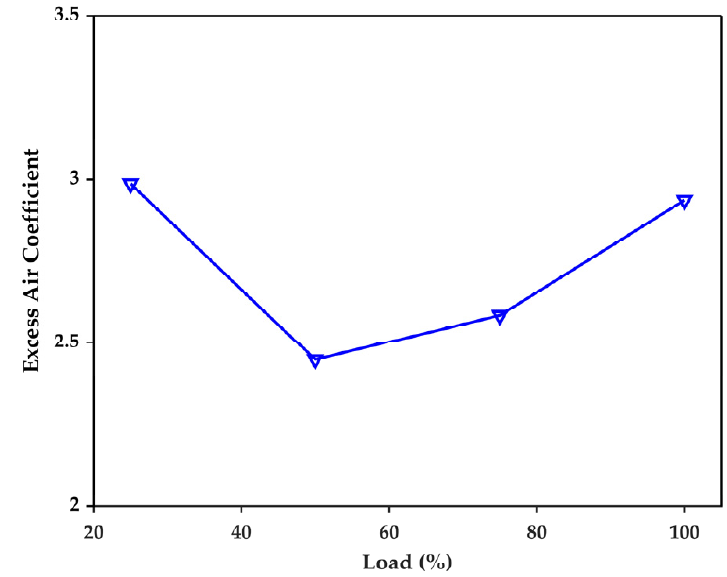
Figure 6. Excess air coefficient variation trend with load.